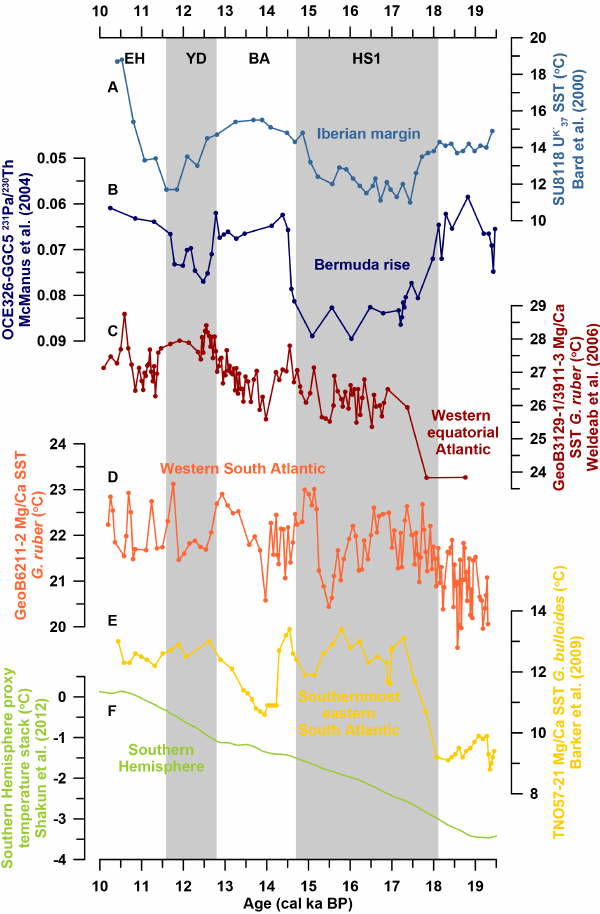
Figure 5. Millennial-scale variability of sea surface temperatures of the Brazil Current spanning Termination 1 compared to available (cid:48) circum-Atlantic records. (a) SU8118 U K -based sea surface tem- 37 peratures (Bard, 2000). (b) OCE326-GGC5 231 Pa / 230 Th-based record of the strength of the Atlantic meridional overturning cir- culation (McManus et al., 2004). (c) GeoB3129-1/3911-3 Glo- bigerinoides ruber (white) Mg / Ca-based sea surface temperatures (Weldeab et al., 2006). (d) GeoB6211-2 Globigerinoides ruber (white) Mg / Ca-based sea surface temperatures. (e) TN057-21 Glo- bigerina bulloides Mg / Ca-based sea surface temperatures (Barker et al., 2009). (f) Southern Hemisphere proxy temperature stack (Shakun et al., 2012). Grey vertical bars depict Heinrich Stadial 1 (HS1) (Sarnthein et al., 2001) and the Younger Dryas (YD) (Ras- mussen et al., 2006). BA: Bølling–Allerød; EH: early